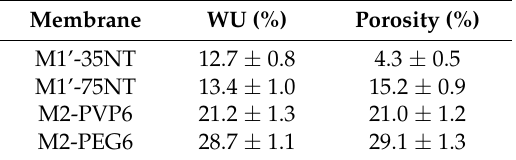
Table 4. WU and porosity values for the membranes M1’-35NT, M1’-75NT, M2-PVP6, and M2-PEG6.